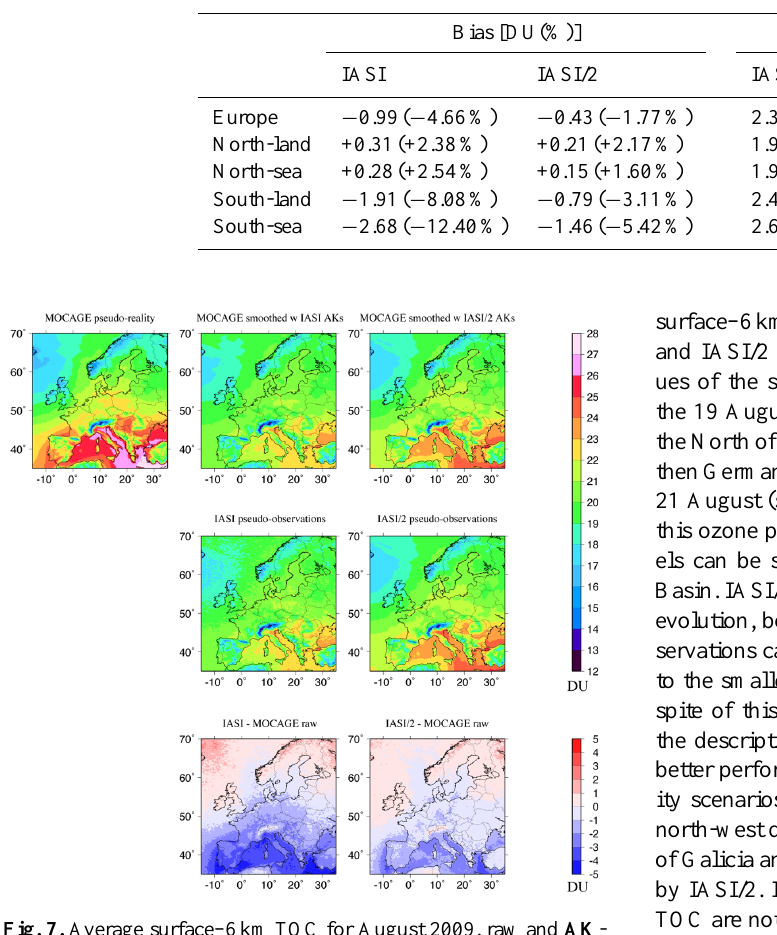
Fig. 7. Average surface–6km TOC for August 2009, raw and AK - smoothed MOCAGE pseudo-reality (top), IASI and IASI/2 pseudo- observations (middle), differences (bottom) of IASI and IASI/2 pseudo-observations with respect to raw MOCAGE